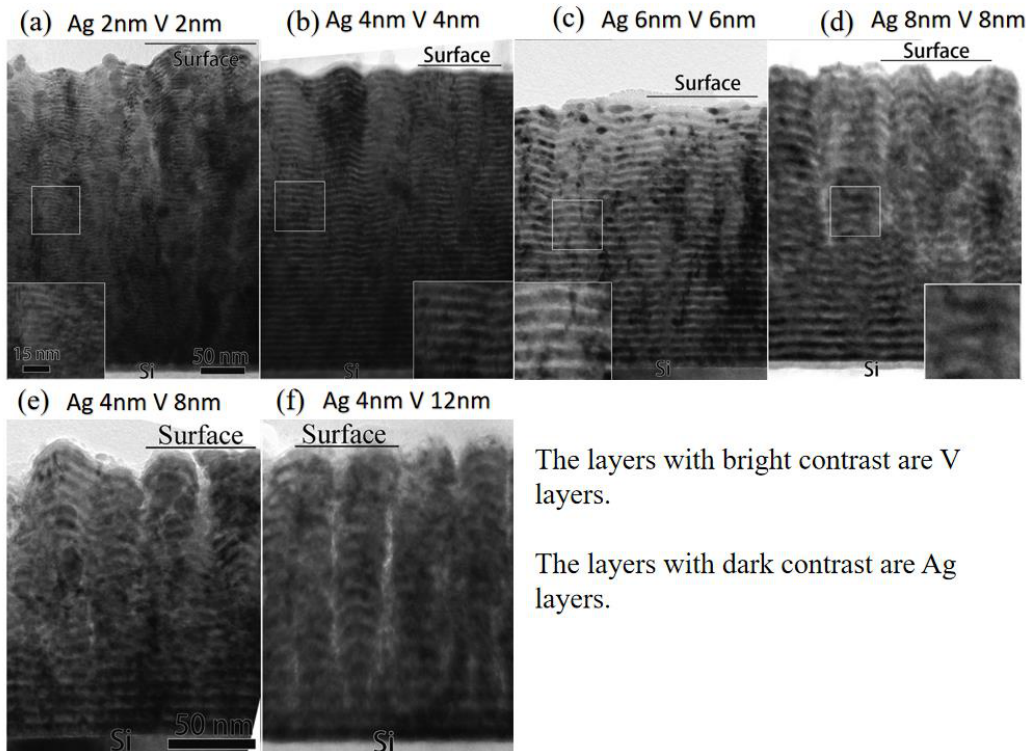
Figure 6. Cross-sectional TEM micrographs of Ag/V multilayer films, showing the influence of layer thickness on microstructure. The individual layer thicknesses of Ag/V multilayer films are ( a ) 2 nm, ( b ) 4 nm, ( c ) 6 nm, and ( d ) 8 nm. ( e ) The thicknesses of V and Ag layers are 8 and 4 nm, respectively. ( f ) The thicknesses of V and Ag layers are 12 and 4 nm, respectively [74]. Reprinted with permission from [74] Elsevier 2014.